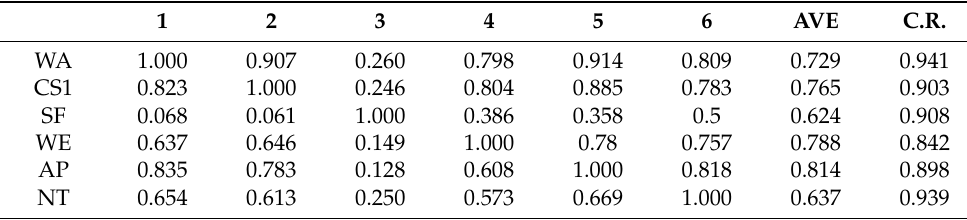
Table 5. Measurement model results ( n = 170).